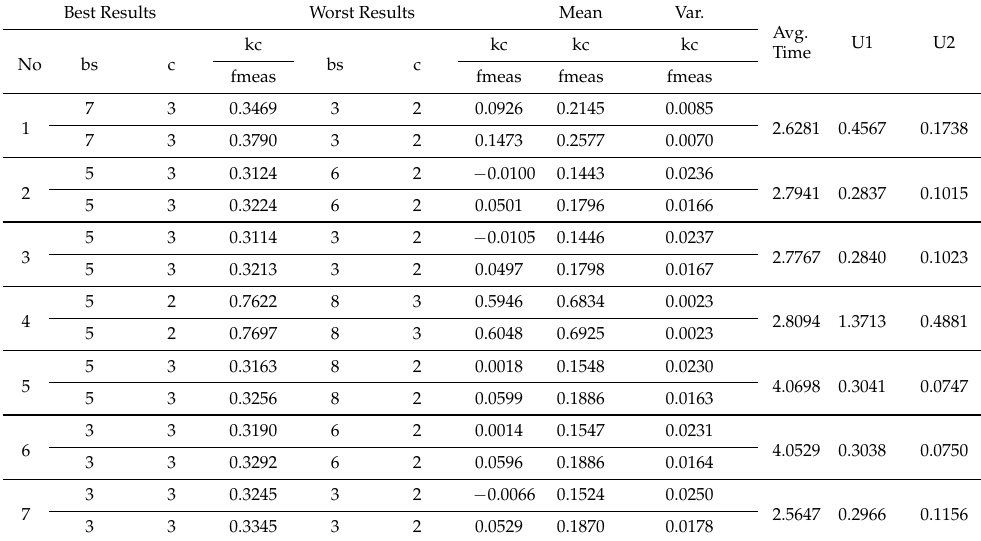
Table A4. Results of Yellow River Estuary